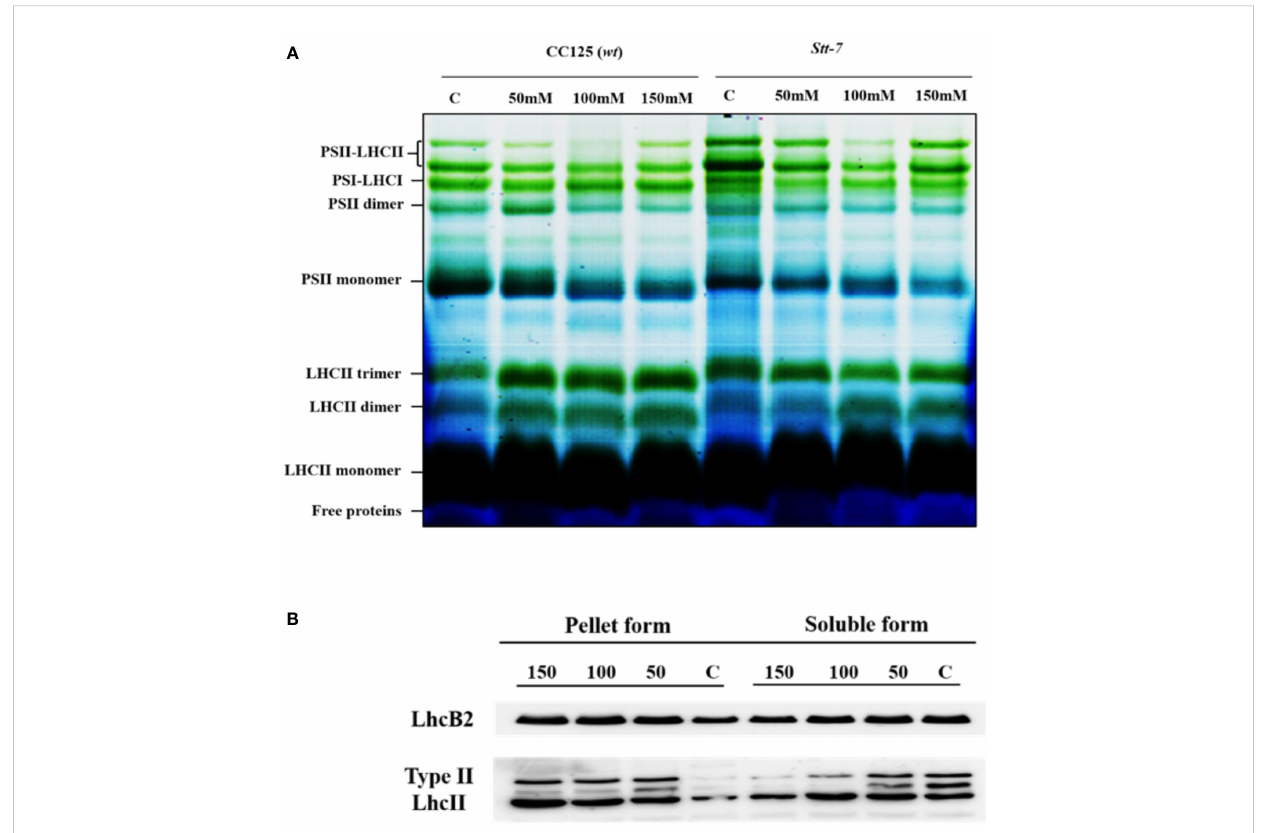
FIGURE 8 Blue native PAGE and Western blot from 0, 100, and 150 mM salt-treated conditions. (A) Blue-native gel electrophoresis of thylakoid membranes solubilized with 0.8% b -DM isolated from C. reinhardtii WT (CC125) and stt7 cells grown in media with 0, 50, 100, and 150 mM NaCl. 8 µg of Chl was loaded into each lane. (B) Thylakoids isolated from 0-, 50-, 100-, and 150-mM sodium chloride treated cells solubilized with mild detergent 0.3% of a -DM + 0.5% of Digitonin based on equal Chl (30 µg). The soluble form (20 µl) was collected for SDS gel electrophoresis. The remaining insoluble pellet was solubilized with SDS sample buffer containing 0.1 M dithiothreitol (DTT), 10% SDS, 0.5M Tris in control as well as (50, 100, and 150) mM salt-treated samples which were fractionated by SDS-PAGE to demonstrate the appearance of Lhcb2 and